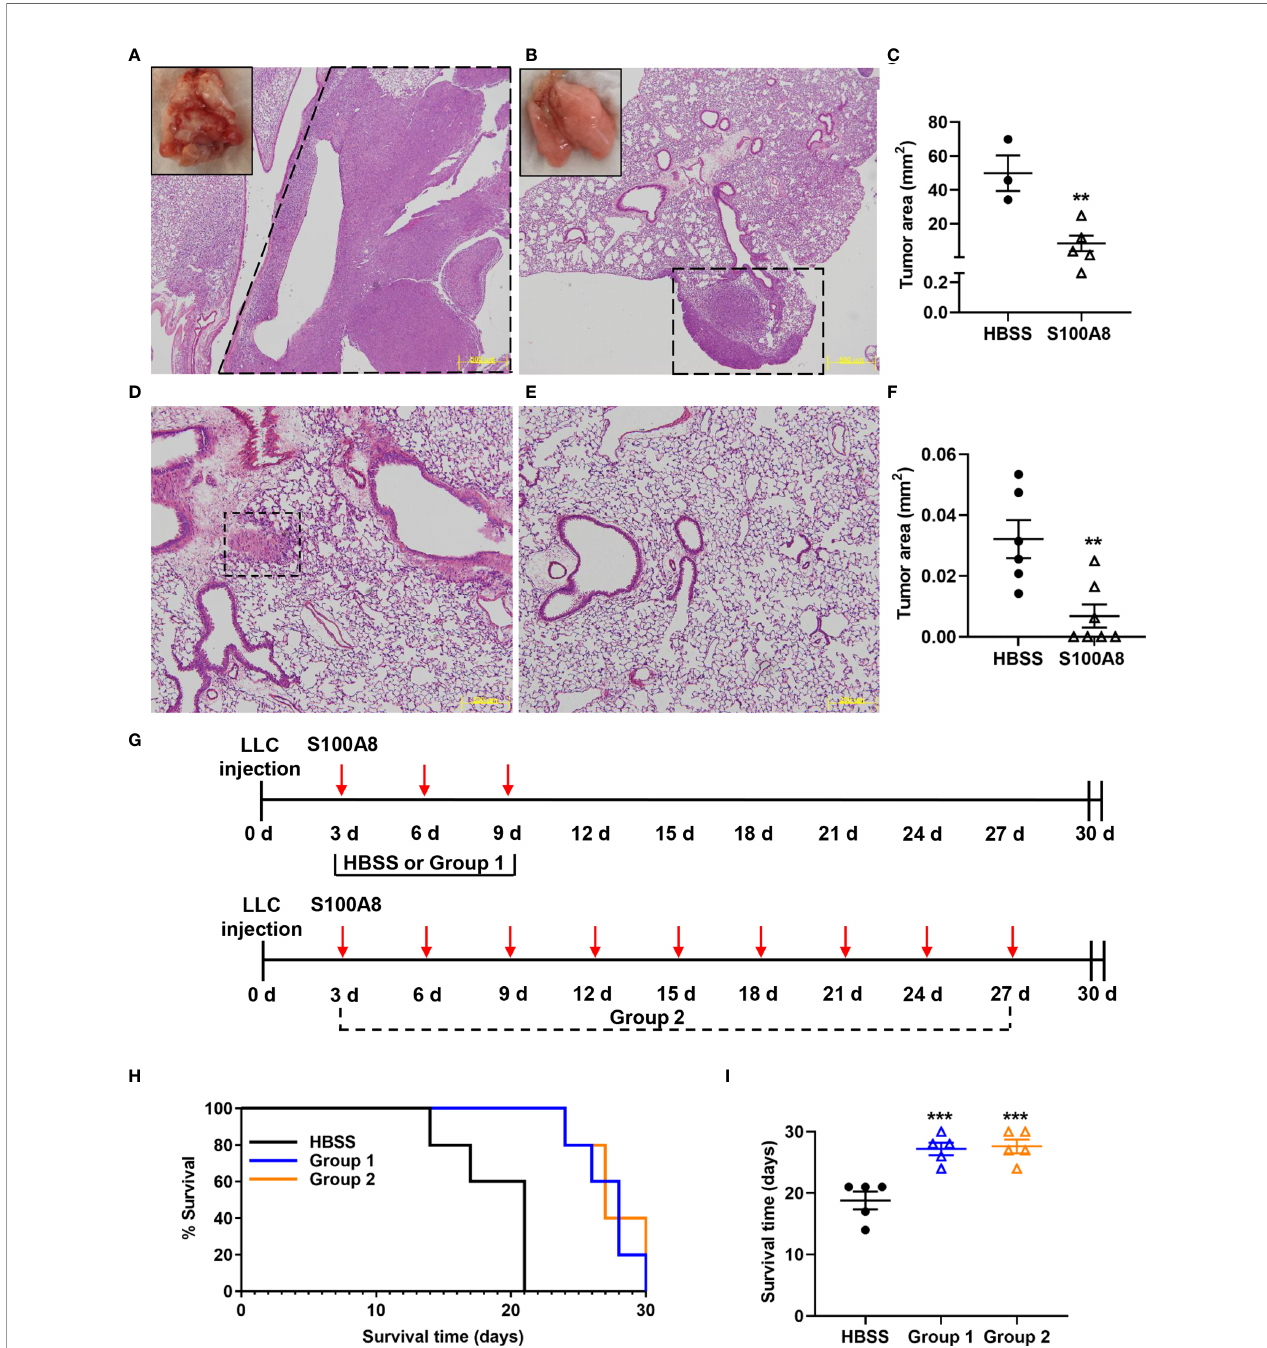
FIGURE 1 | Intranasal S100A8 treatments delayed lung tumor growth and prolonged survival in mice. (A, B) Representative Hematoxylin and Eosin (H&E)-stained sections of mouse lungs after a single treatment of Hank ’ s Balanced Salt Solution (HBSS, control) (A) or mouse recombinant S100A8 (10 µg) (B) . Lungs were harvested after 20 days, scale bar, 500 m m, dotted line = tumors. Insets show corresponding macroscopic morphology of whole lungs. (C) Graph showing mean total tumor area ± SEM (mm 2 ) in lungs from mice treated with HBSS or S100A8, n = 3-5 mice per treatment group, **p < 0.01. (D – F) Representative H&E-stained sections of mouse lungs after three treatments with HBSS (control) (D) or mouse recombinant S100A8 (10 µg) (E) on Days 0, 3 and 6 post-LLC cell implantation. Lungs were harvested on Day 9, dotted line = tumors; scale bar, 200 m m. (F) Graph showing mean total tumor area ± SEM (mm 2 ) in lungs from mice after three treatments with HBSS or S100A8, n = 6- 7 mice per treatment group, **p < 0.01. (G) Schematic diagrams showing treatment protocols for intranasal S100A8 delivery or HBSS; S100A8 treatments were given on days 3, 6 and 9 post-LLC cell implantation (Group 1) or every third day until endpoint (Group 2). (H) Kaplan-Meir curve showing mouse survival for each treatment group (n = 5 mice per treatment group). (I) Graph showing the mean survival days ± SEM for mice given S100A8 or HBSS, ***p < 0.001 compared to